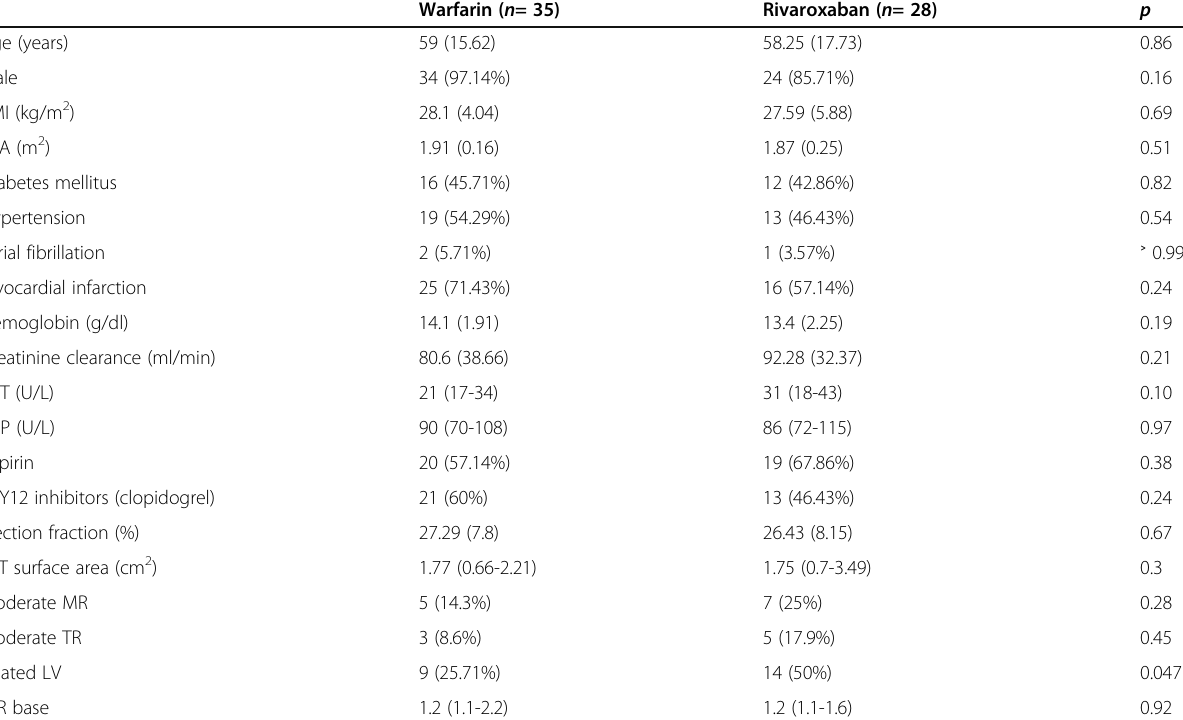
Table 1 Comparison of baseline data between warfarin and rivaroxaban